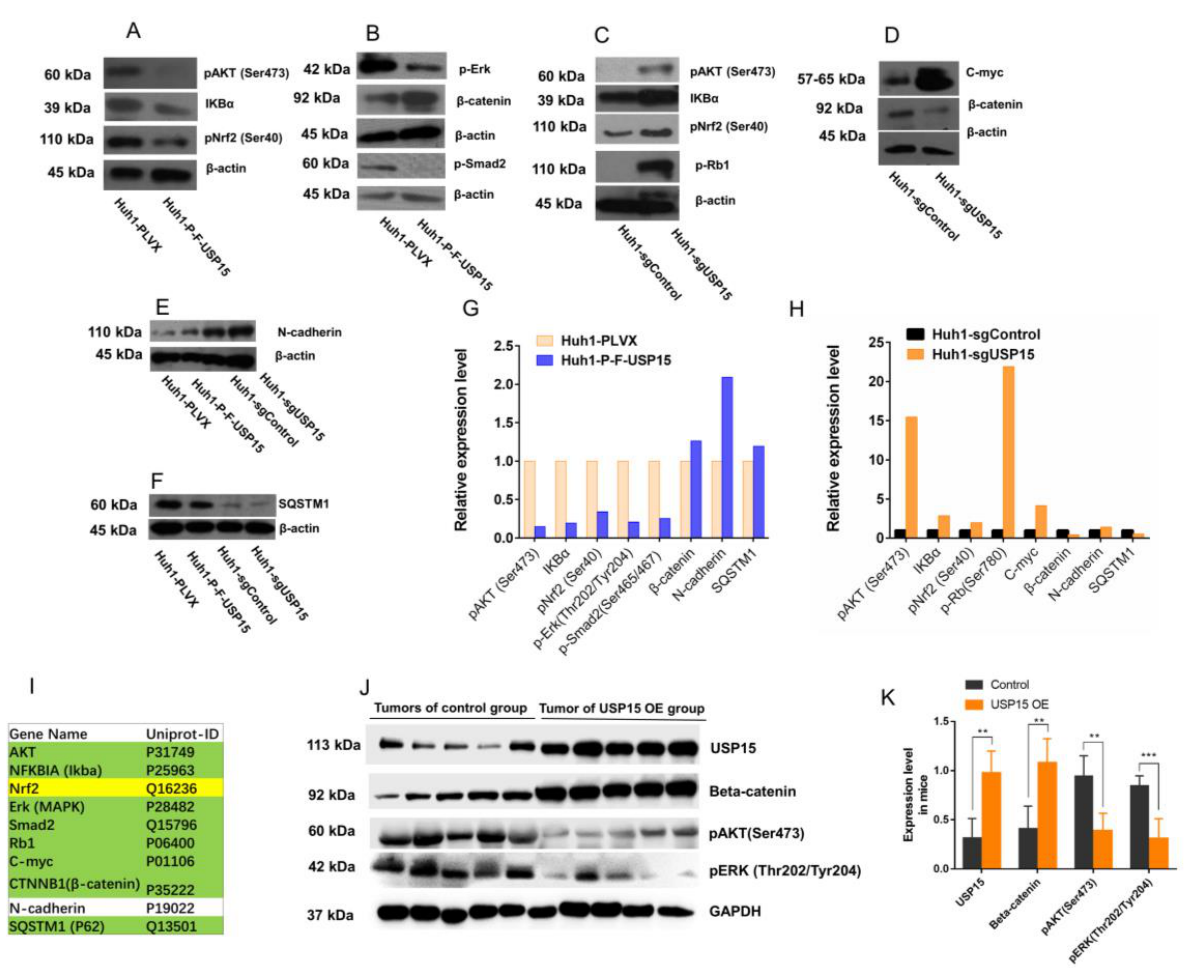
Figure 4. Tumor-related proteins can be regulated by USP15 via interactions mediated by other proteins. ( A ) Western blots of protein IKB α and phosphorylated proteins p-Nrf2 and p-AKT in cell lines Huh1-P-F_USP15 (overexpressing USP15) and Huh1-PLVX (control). ( B ) Western blots of protein β -catenin and phosphorylated proteins, p-Smad2 and p-Erk in cell lines Huh1-P-F_USP15 (overexpressing USP15) and Huh1-PLVX (control). ( C ) Western blots of proteins IKB α and phosphorylated proteins p-Nrf2, p-Rb1, and p-AKT in cell lines Huh1-sgUSP15 (knockout USP15) and Huh1-sgControl (control). ( D ) Western blots of proteins C-myc and β -catenin in cell lines Huh1-sgUSP15 (knockout USP15) and Huh1-sgControl (control). ( E ) Western blots of proteins N-cadherin in cell lines Huh1-P-F_USP15 (overexpressing USP15) and Huh1-sgUSP15 (knockout USP15) versus control. ( F ) Western blots of proteins SQSTM1 in cell lines Huh1-P-F_USP15 (overexpressing USP15) and Huh1-sgUSP15 (knockout USP15) versus control. ( G ) Bar plot of intensities, normalized to ß-actin, with (Huh1-P-F_USP15) and without (Huh1-PLVX) overexpression of USP15. Only differentially expressed proteins are shown. ( H ) Bar plot of intensities, normalized to ß-actin, with (Huh1-sgUSP15) and without (Huh1-sgControl) knockout of USP15. Only differentially expressed proteins are shown. ( I ) List of investigated proteins. Interaction partners of USP in the human USP PPI network are regulated by USP15 and highlighted in green. Nrf2 and N-caderin are not members of the human USP PPI network. Whereas Nrf2 (highlighted yellow) is regulated by USP15, N-caderin is not. ( J ) Western blots of downstream proteins of USP15 in tumor samples. The left side is the tumor of HCC cell lines, Huh7-PLVX, which is used as control. The right side is the tumor of Huh7-P-F-USP15 ( K ). Band densitometry intensity ration of the Western blot in picture ( J ). **: p < 0.01; ***: p < 0.001.